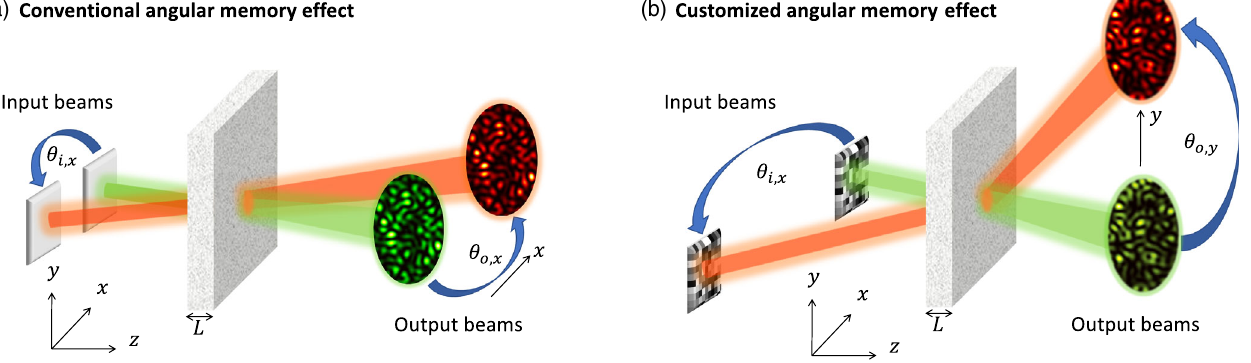
FIG. 1. Conventional versus customized angular memory effect. (a) Schematic of the conventional angular memory effect: a beam of coherent light (wavelength λ ) is impinging onto a diffusive slab of thickness L . When the incident beam is tilted by a small angle θ < λ = ð 2 π L Þ , the transmitted pattern tilts in the same direction by θ i;x both the input and the output tilt angles can be chosen arbitrarily for a special incident wave front. In this example, when the input wave front is tilted by θ i;x in ˆ x direction, the output wave front tilts in ˆ y direction by j θ o;y j ≠ j θ i;x j